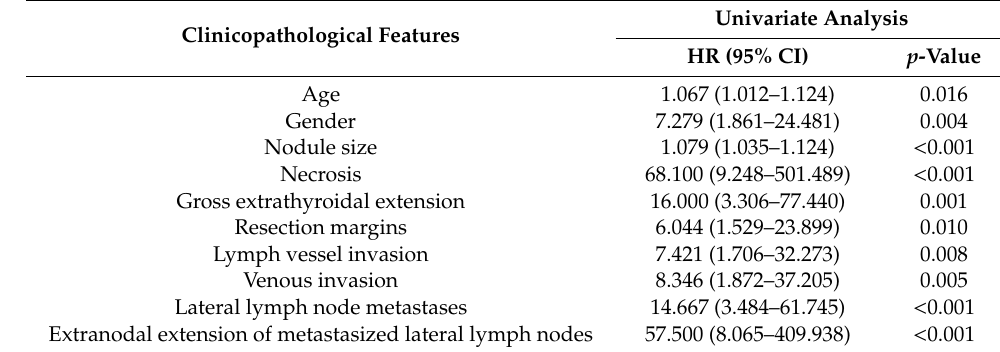
Table 5. Univariate analysis regarding PTC disease-specific mortality.